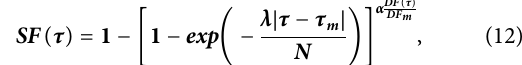
TABLE 1 | Comparison of RMS, SNR, CC, and time cost among different denoising approaches. Method